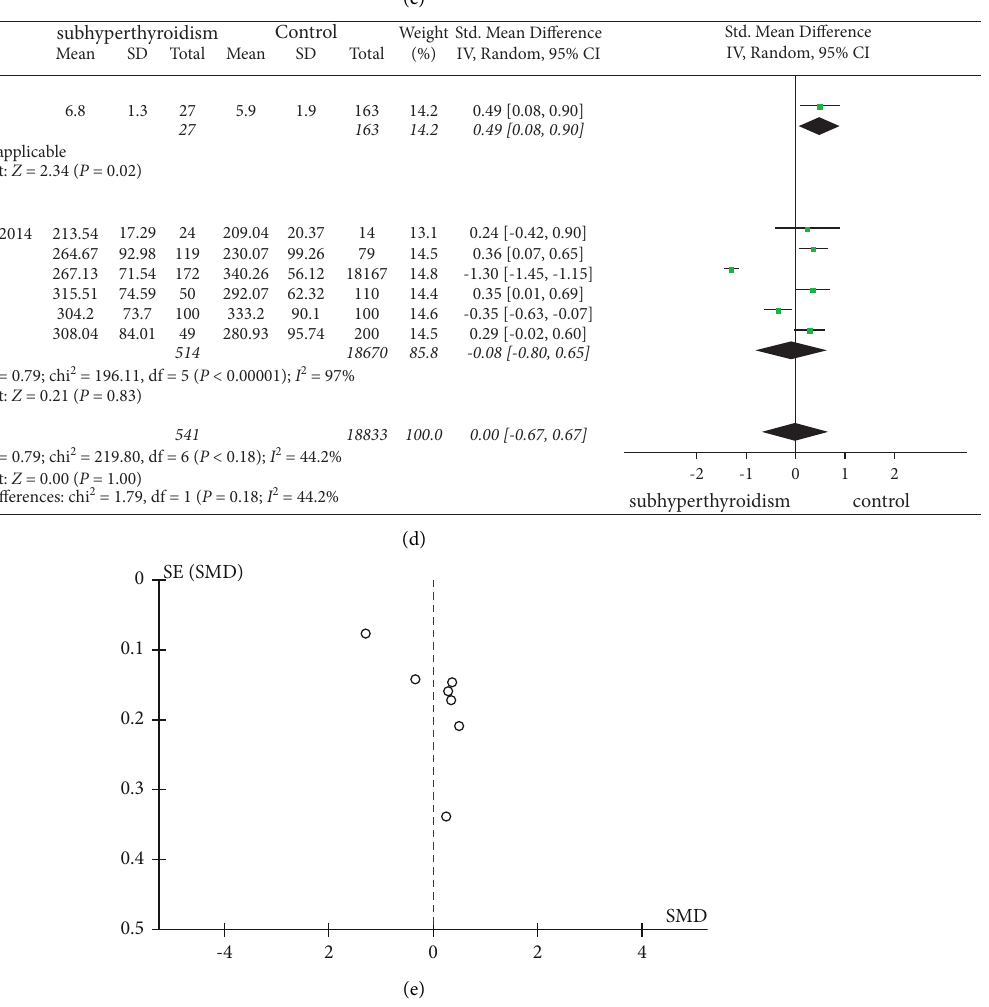
Figure 4: (a) Forest plot of subclinical hyperthyroidism and uric acid. (b) Subgroup analysis of subclinical hyperthyroidism, grouped by area. (c) Subgroup analysis of subclinical hyperthyroidism, grouped by age. (d) Subgroup analysis of subclinical hyperthyroidism, grouped by basic diseases. (e) Funnel plot of subclinical